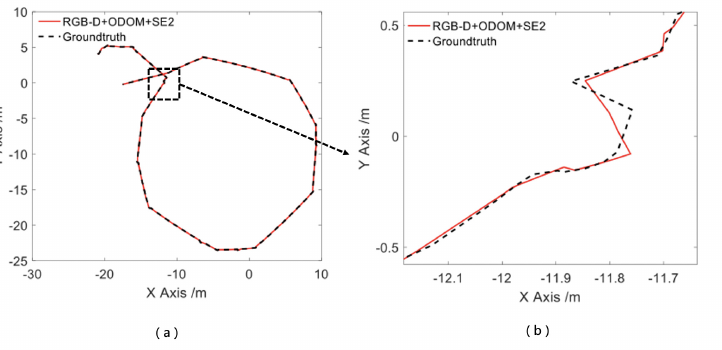
Figure 10. ( a ) Proposed fusion positioning system and RTK trajectory; ( b ) The zoomed area of